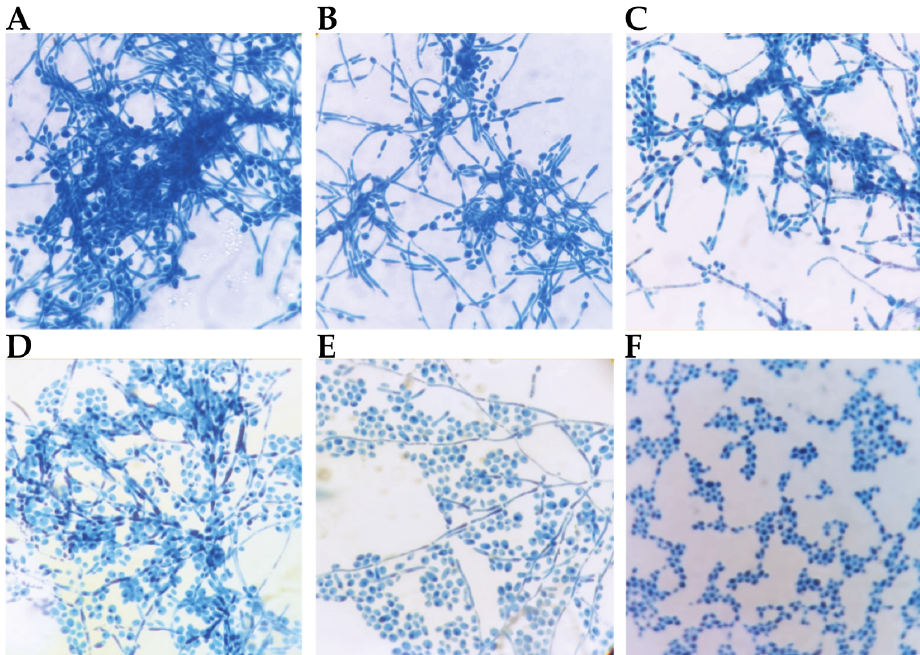
Figure 3. Light-microscopy images taken at 100× magnification of C. albicans ATCC 10231 stained with 0.3% crystal violet, without ( A ) or with the addition of PYED-1 solutions at 2 µg/mL ( B ), 4 µg/mL ( C ), 8 µg/mL ( D ), 16 µg/mL ( E ) and 32 µg/mL ( F ). The filamentation of C. albicans induced by serum was effectively suppressed in the presence of PYED-1 in RPMI-FBS (fetal bovine serum) medium in a concentration- dependent manner. After 5 h of drug exposure, PYED-1 fully inhibited hyphae formation of C. albicans ATCC 10,231 strain at 32 µg/mL, as compared to the untreated control. Microscopic images of C. albicans untreated or treated with 2 µg/mL and 4 µg/mL of PYED-1 formed long hyphae (Figure 3A–C). In cells treated with 8 µg/mL and 16 µg/mL of the drug, fewer filaments and more yeasts per field were observed (Figure 3D,E).